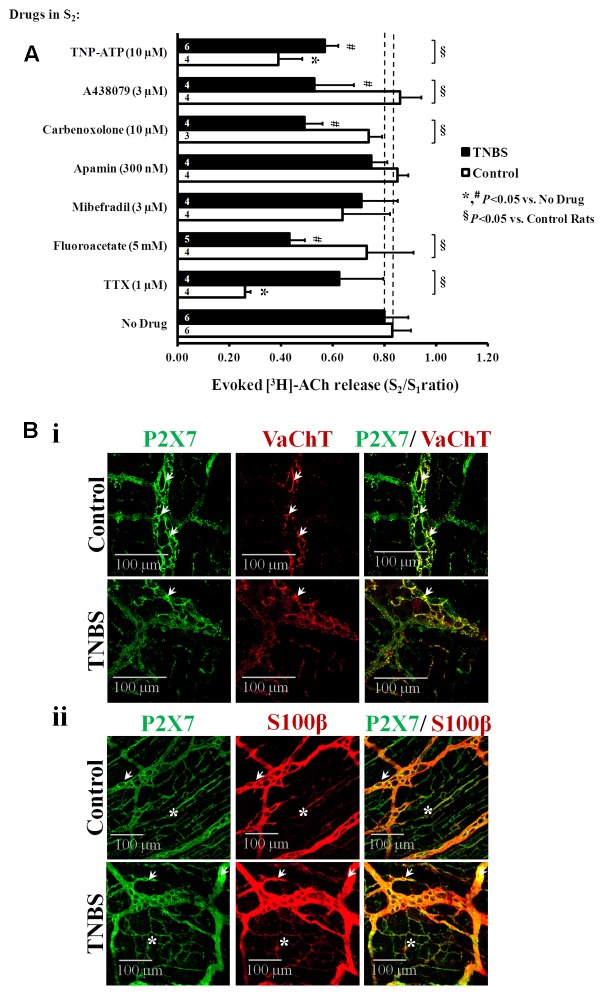
(A) Effects of TTX (1 μM, a nerve action potential blocker), sodium fluoroacetate (5 mM, a glial cell metabolism uncoupler), mibefradil (3 μM, an inhibitor of Cav3 (T-type) channels existing in ICCs), apamin (0.3 μM, an inhibitor of small-conductance KCa2 (SK3) channels characteristic of FLCs), carbenoxolone (10 μM, a pannexin-1 inhibitor), A438079 (3 μM, a P2X7 receptor antagonist) and TNP-ATP (10 μM, a blocker of ionotropic P2X2 and P2X2/3 receptors) on electrically evoked [3H]-ACh release from the LM-MP of the rat ileum of control and TNBS-treated rats. After loading and washout periods, [3H]ACh release was elicited by two trains (S1 and S2) of electrical field stimulation, each consisting of 200 pulses delivered at a 5 Hz frequency. Drugs were applied 8 min before S2. Abscissa is changes in S2/S1 ratios compared to the S2/S1 ratio obtained without addition of any drug. The data are means ± SEM of three to six individuals. ∗,#P < 0.05 (unpaired Student’s t-test with Welch correction) represent significant differences from the situation where no drugs were added to control and TNBS-treated preparations, respectively (dashed vertical lines); §
P < 0.05 (unpaired Student’s t-test with Welch correction) represent significant differences from control animals. Confocal micrographs of whole-mount preparations of the longitudinal muscle-myenteric plexus of the ileum from control and TNBS-treated rats. Shown is the P2X7 receptor immunoreactivity in preparations also stained against the vesicular ACh transporter (VAChT, Bi) and the enteric glial cell marker (S100β, Bii). The P2X7 receptor co-localizes partially with VAChT at the ganglion level (Bi, white arrows); a more extensive co-localization exists between the P2X7 receptor and the glial cell marker, S100β (Bii), both at myenteric ganglia (white arrows) and at the neuromuscular layer (asteriks) of control and TNBS-treated preparations. Z-stack images are representative of at least four animals per group. Scale bar = 100 μm.